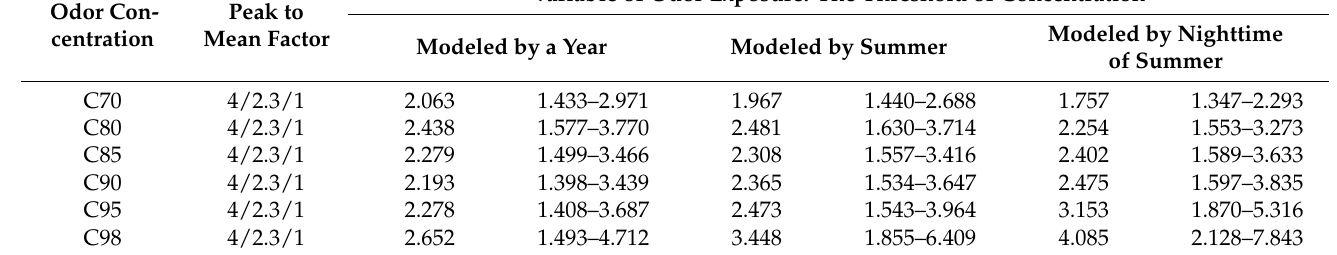
Table 2. OR values for odor annoyance by binomial logistic regression models a,b